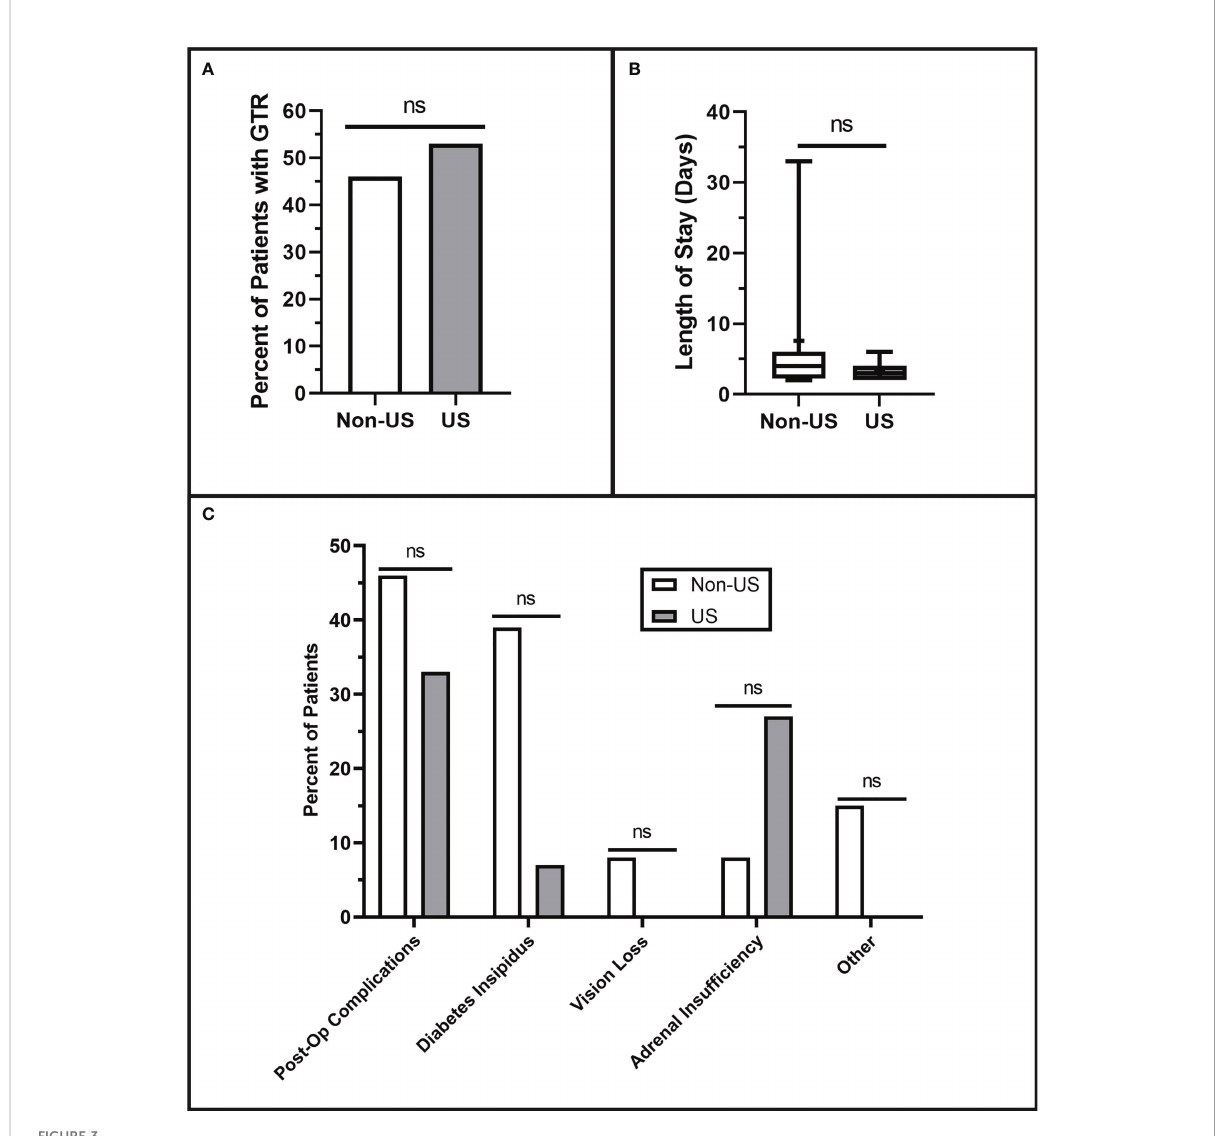
FIGURE 3 Postoperative Resection Results. (A) Qualitative extent of tumor resection was classi fi ed as either gross total (GTR) or subtotal. The extent of resection was determined based on the interpretation of each patient ’ s three-month postoperative MRI. No differences were observed in qualitative extent of resection (p = 0.716). (B) Length of hospital stay showed no difference between the groups (p = 0.155). (C) There were no signi fi cant differences in the numbers of postoperative complications (p = 0.488) including diabetes insipidus (p = 0.069), vision loss (p = 0.464), adrenal insuf fi ciency (p = 0.333), or other complications (P = 0.206). Values that did not reach the threshold for signi fi cance (p= <0.05) were labeled as non-signi fi cant